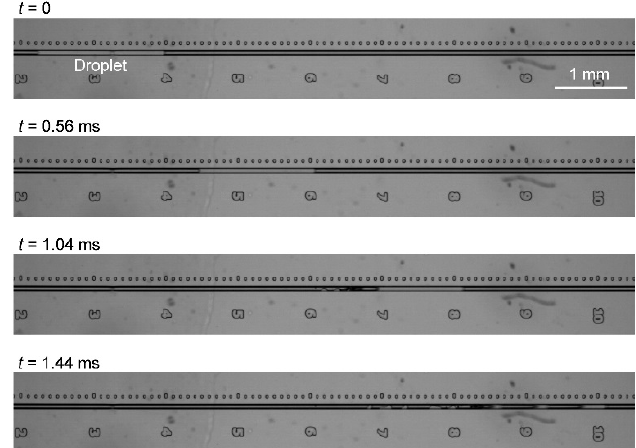
Figure 2. Images of a droplet in a microchannel with L = 2.00 mm at an applied pressure of 1800 kPa. t = 0 is defined as the time at which the droplet front passes the point 4 mm from the launching point.